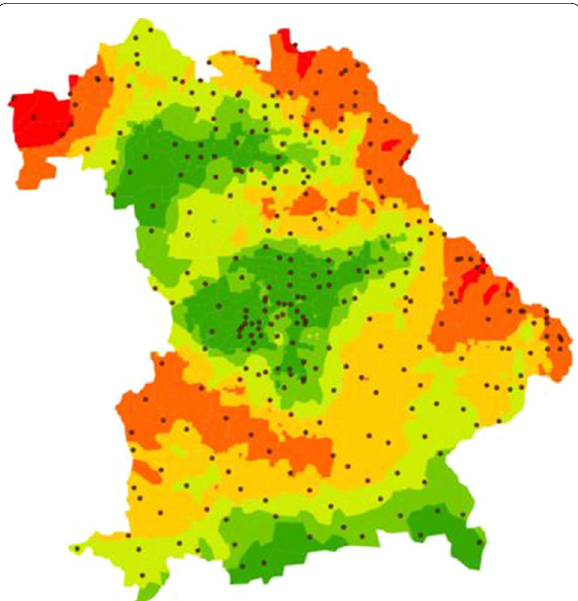
Fig. 4 Distribution of 6 differing subspaces of PCDD/F-concentra- tions in organic